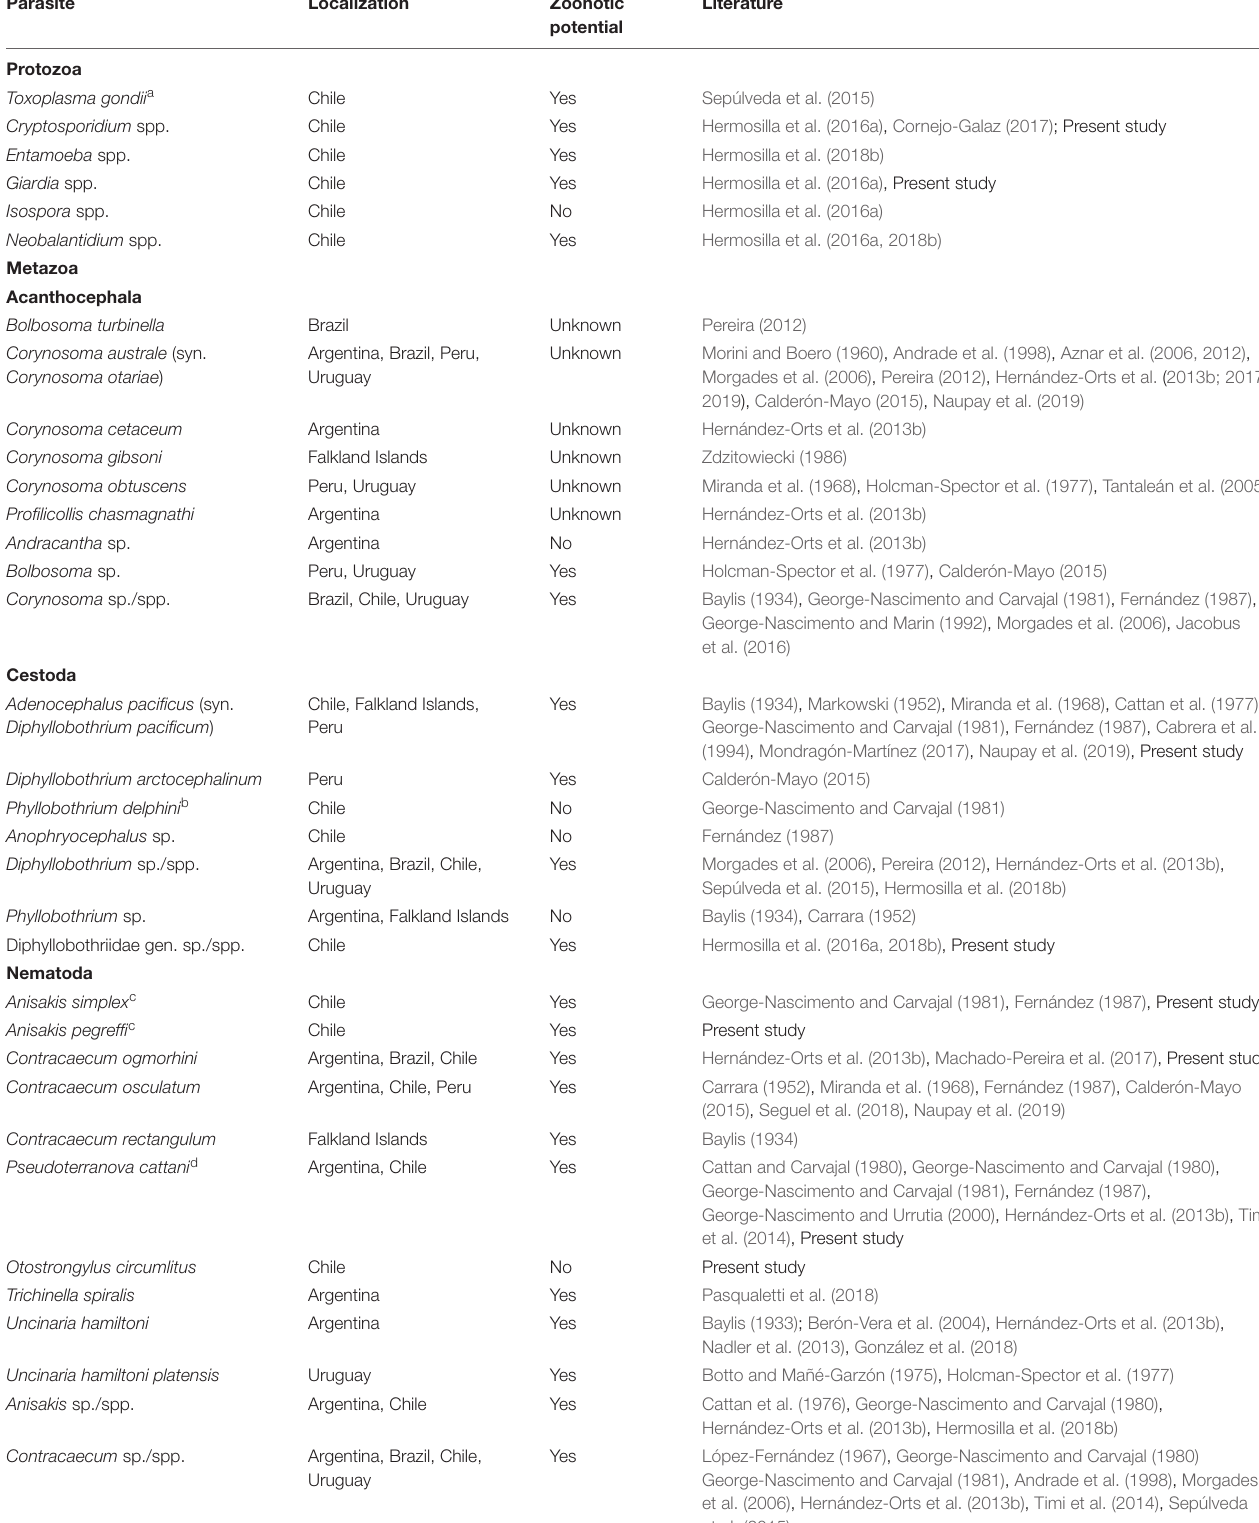
TABLE 1 | List of endoparasites reported from South Americans sea lions ( Otaria flavescens ), including findings of present